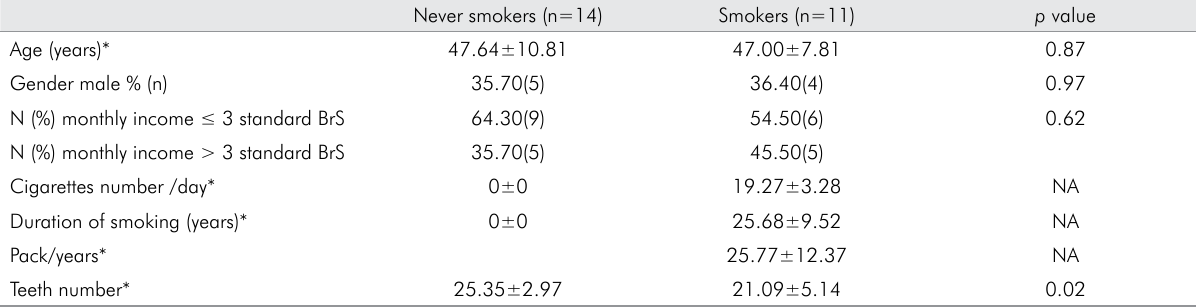
Table 1. Baseline demographical characteristics of the subjects that completed the study’s